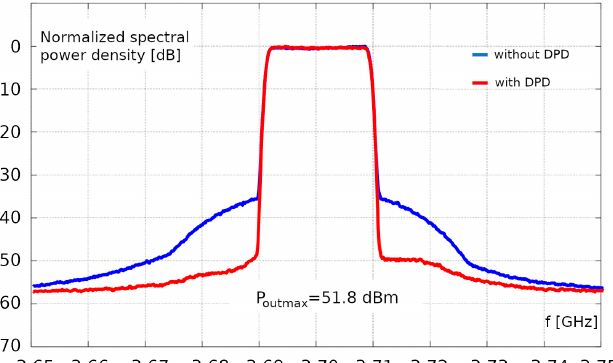
Figure 5. Prototype of the 4-channel RF front-end for the LTE band B43 (PCB dimensions: 30 × 33 cm).